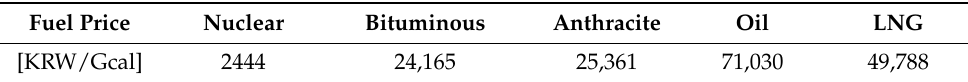
Table 5. Fuel Price (2019~2021 average).